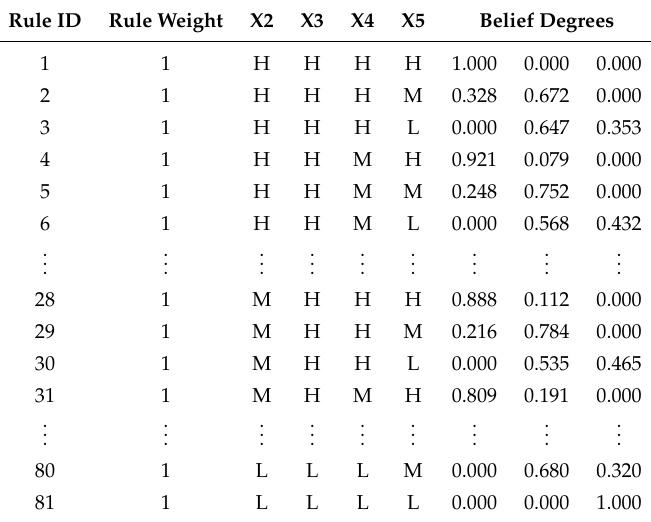
Table 4. Initial Belief Rule Base for conjunctive